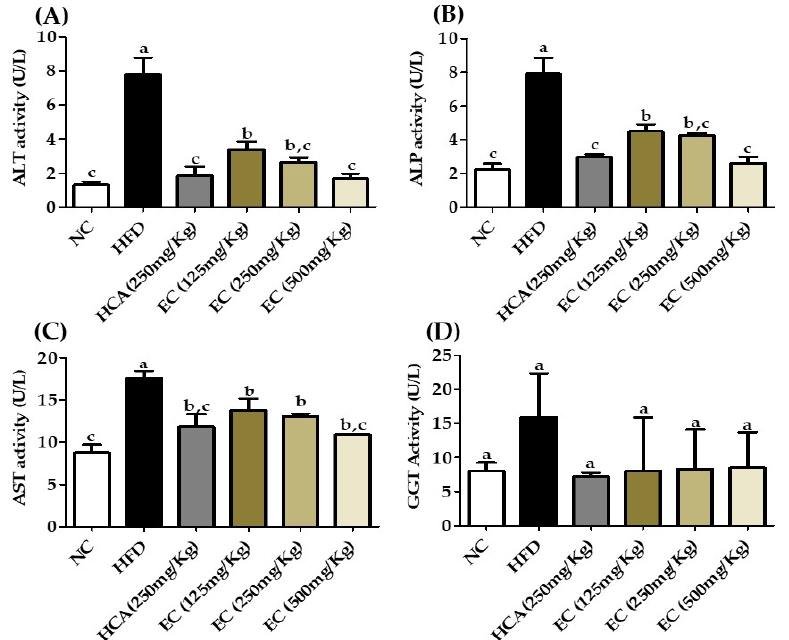
Figure 9. The effects of Ecklonia cava ethanol (70%) extract (ECE) on plasma biomarkers as liver func- tion enzymes after 8 weeks of feeding of ND; HFD; and 125, 250, and 500 mg/kg b.w of ECE accom- panied by a high-fat diet (HFD). ( A ) alanine aminotransferase (ALT), ( B ) alkaline phosphatase ac- tivity (ALP), ( C ) aspartate aminotransferase activity (AST), and ( D ) gamma-glutamyl transferase activity (GGT). Data are presented as means ± SEM ( n = 8 for each group). Values with different letters present significant differences ( p < 0.05).